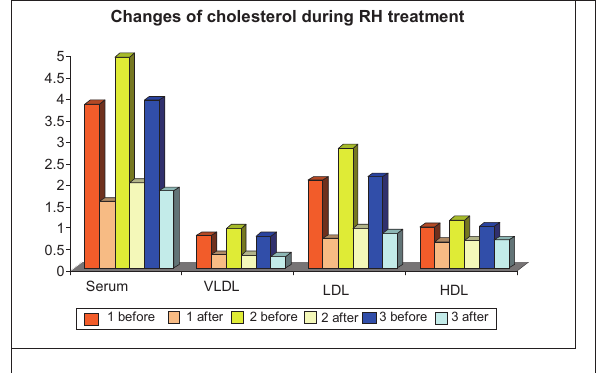
Fig. 2. Changes of cholesterol levels in serum and lipoproteins during RH treatment.